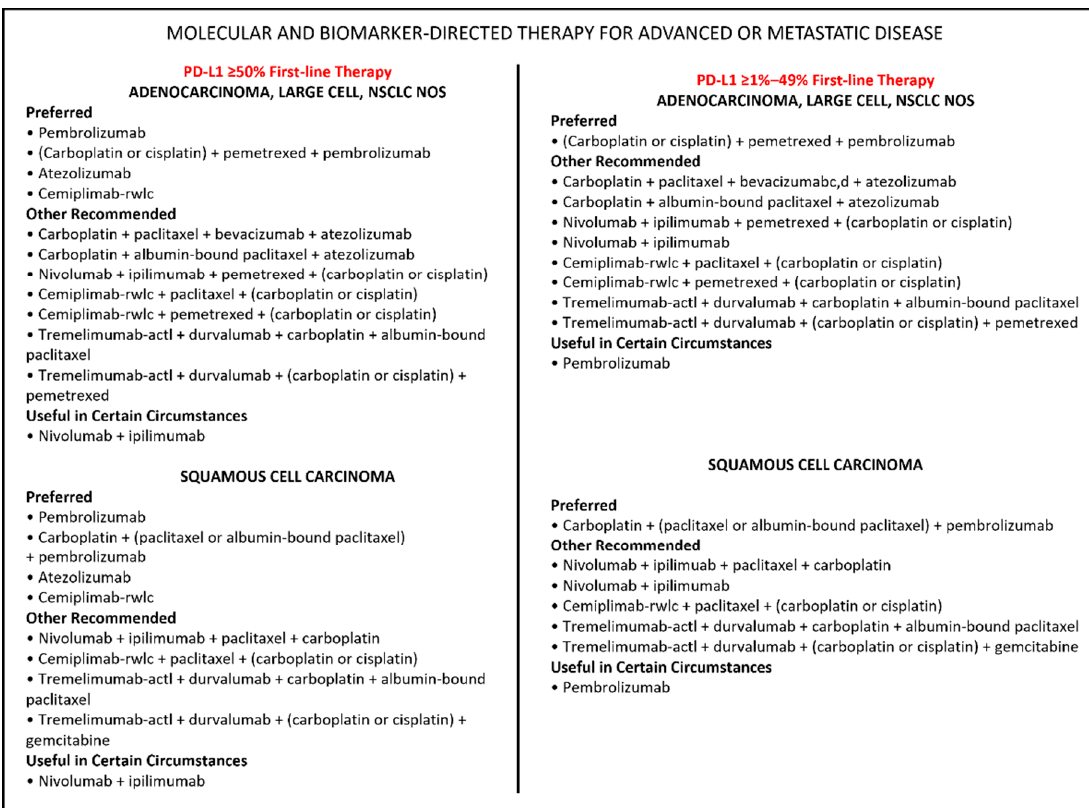
Figure 1. Immunotherapy treatments currently recommended for advanced NSCLC.